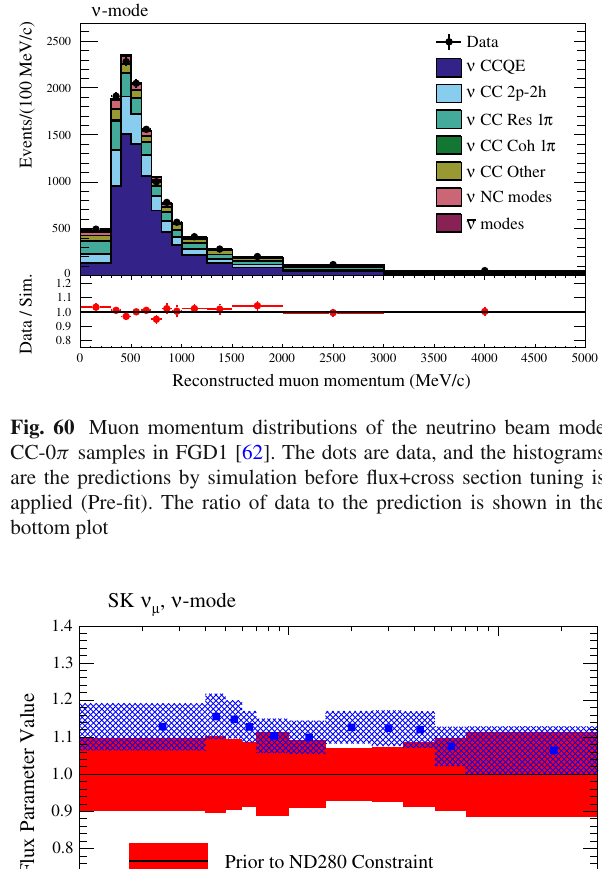
and nucleon binding energy, and final state interactions. The details of the parameterization are found in [62]. Figure 61 shows the result of the flux tuning and Fig. 62 shows that of the cross section parameters. The neutrino cross sections as a function of energy, with an error band corresponding to the uncertainty on the neutrino cross sections due to the error parameters, are shown in Fig. 63. The T2K ND280 measure- ments improved considerably the understanding of neutrino cross sections in low energy ( ∼ 1 GeV). The flux parameters at ND280 are fitted together with the cross-section param- eters and are used to produce a full correlation matrix with the flux parameters at SK. The correlation matrix of the SK flux and cross-section parameters is shown in Fig. 64. The parameters and uncertainties from Fig. 64 are used in the oscillation analysis described in the following